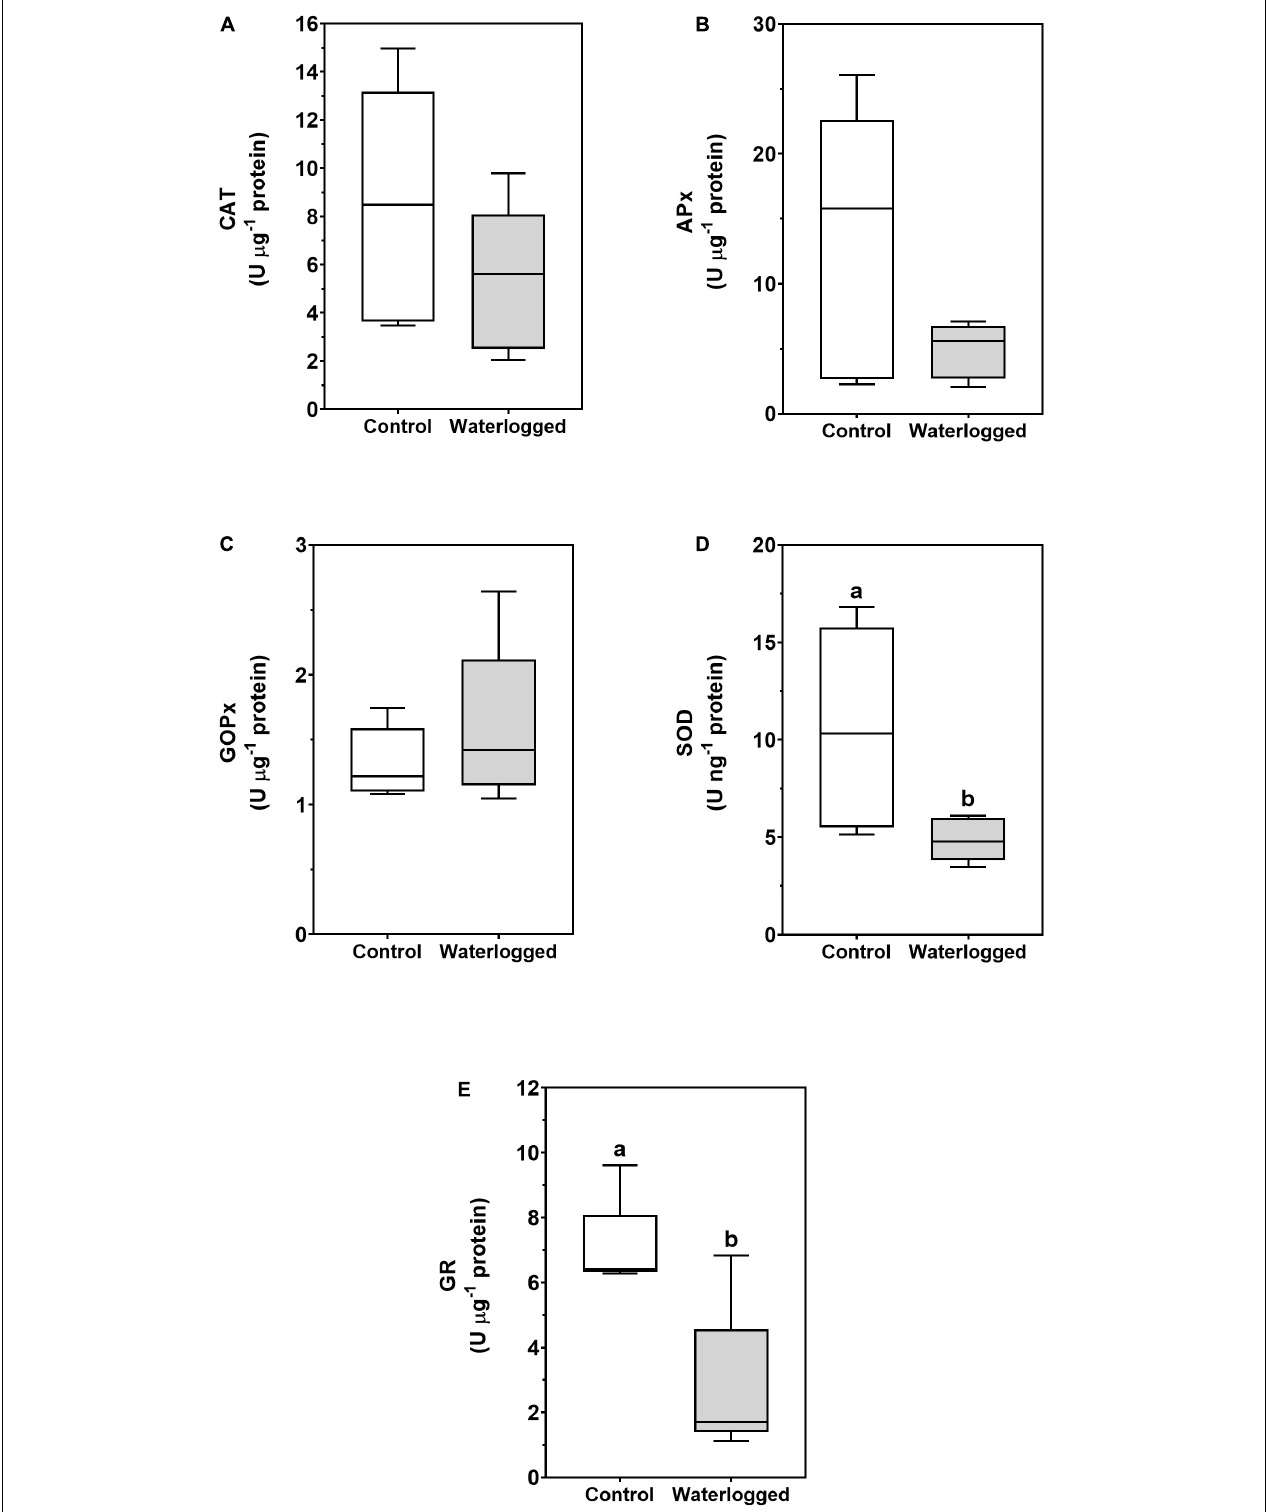
FIGURE 10 | Boxplots of catalase (CAT, A ), ascorbate peroxidase (APX, B ), guaiacol peroxidase (GOPx, C ), superoxide dismutase (SOD, D ) and glutathione reductase (GR, E ) enzymatic activities in leaves of control plants (white boxes) and waterlogged plants (gray boxes) of Spartina patens after 30 days ( n = 5, different letters indicate significant differences at p <